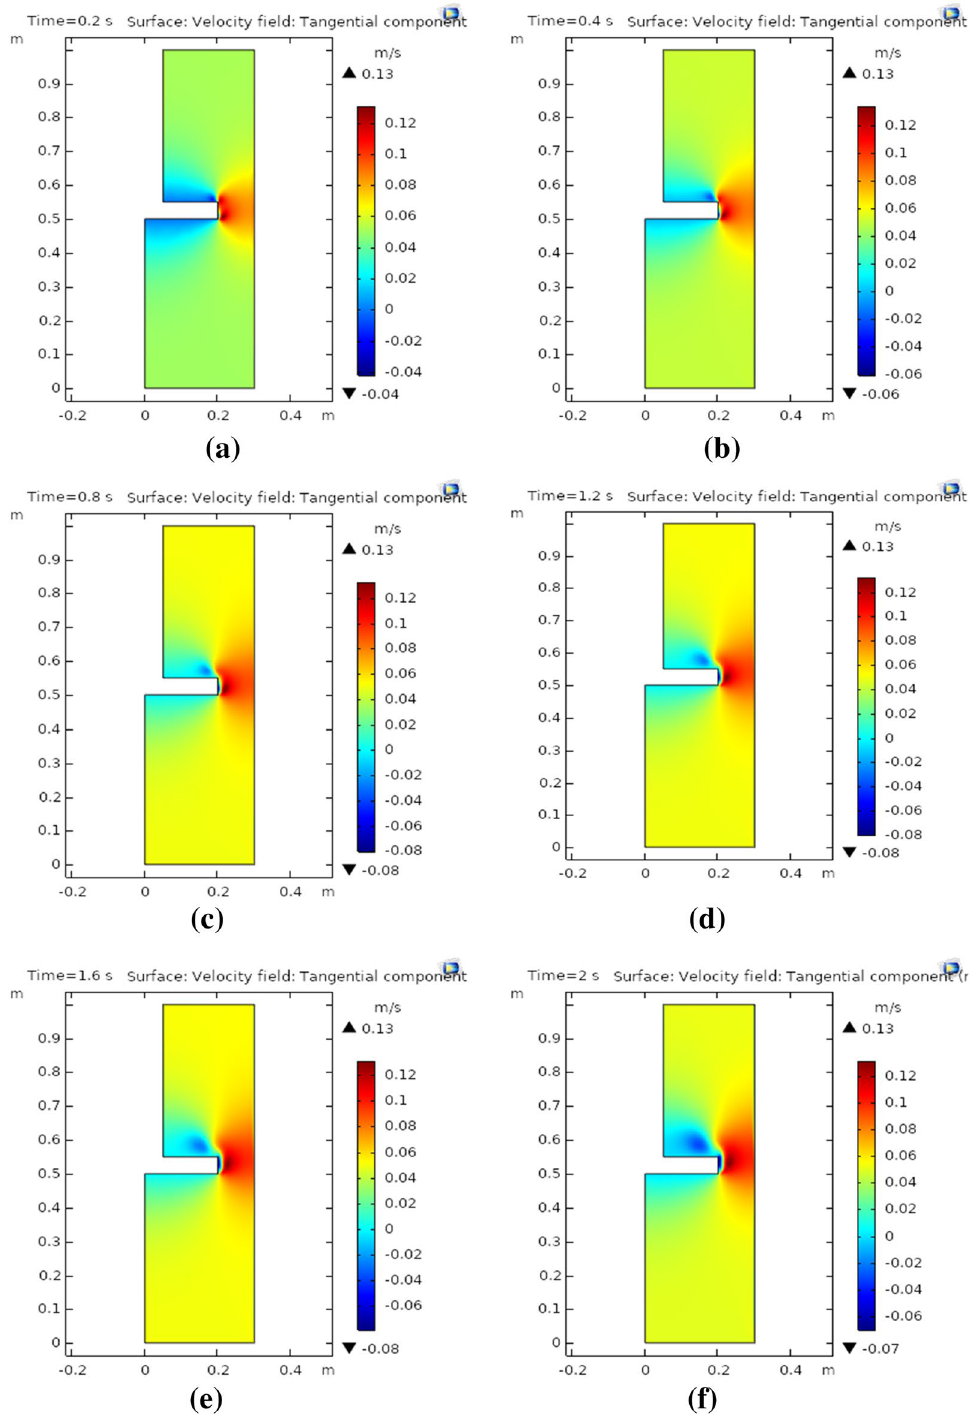
Figure 3. (a) Tangential component at 0.2 s, (b) tangential component at 0.4 s, (c) tangential component at 0.8 s, (d) tangential component at 1.2 s, (e) tangential component at 1.6 s, (f) tangential component at 2